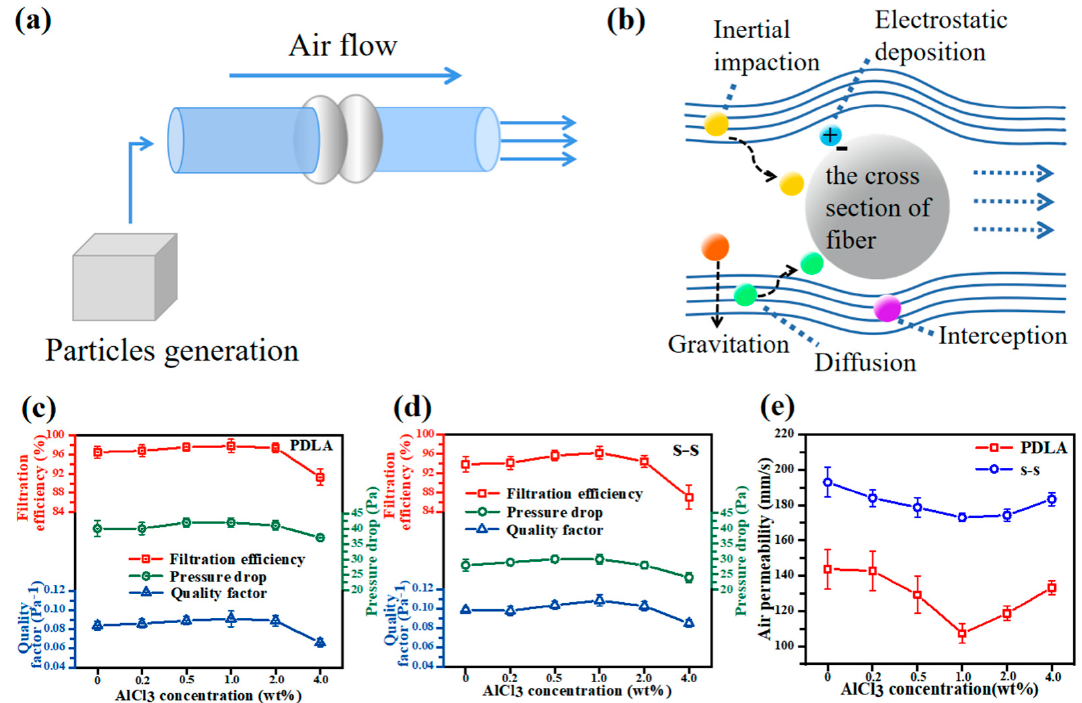
Figure 6. ( a ) The schematic diagram of filtration equipment; ( b ) the filtration mechanism diagram of nanofiber filter materials; the filtration efficiency, pressure drop, and quality factor of ( c ) single-spinning PDLA fibers and ( d ) side-by-side fibers with different AlCl 3 contents; ( e ) the air permeability performance of single-spinning PDLA fibers and side-by-side fibers with different AlCl 3 contents.